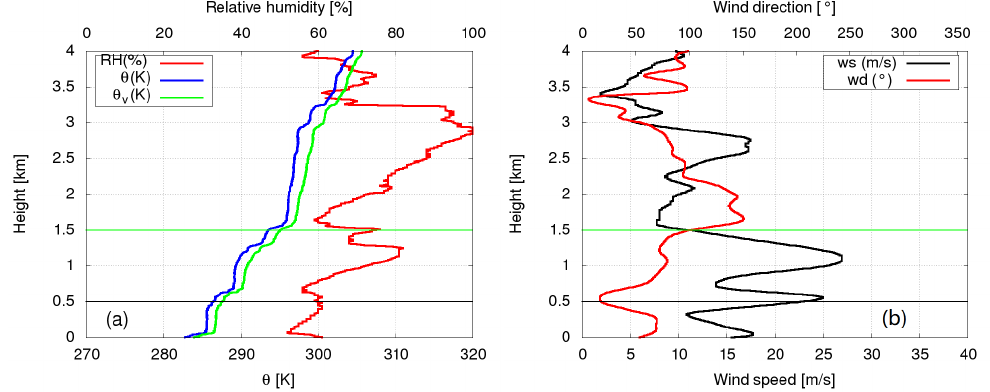
Figure 5. Radiosonde profiles from Rivolto, obtained on 17 November 2017 at 00:00 CET. ( a ) shows potential temperature (blue), virtual potential temperature (green) and RH (red). ( b ) shows wind speed (black) and wind direction (red). Horizontal lines 1.5km denote significant gradient changes in the RH, potential temperature and wind speed profiles. The height is relative to